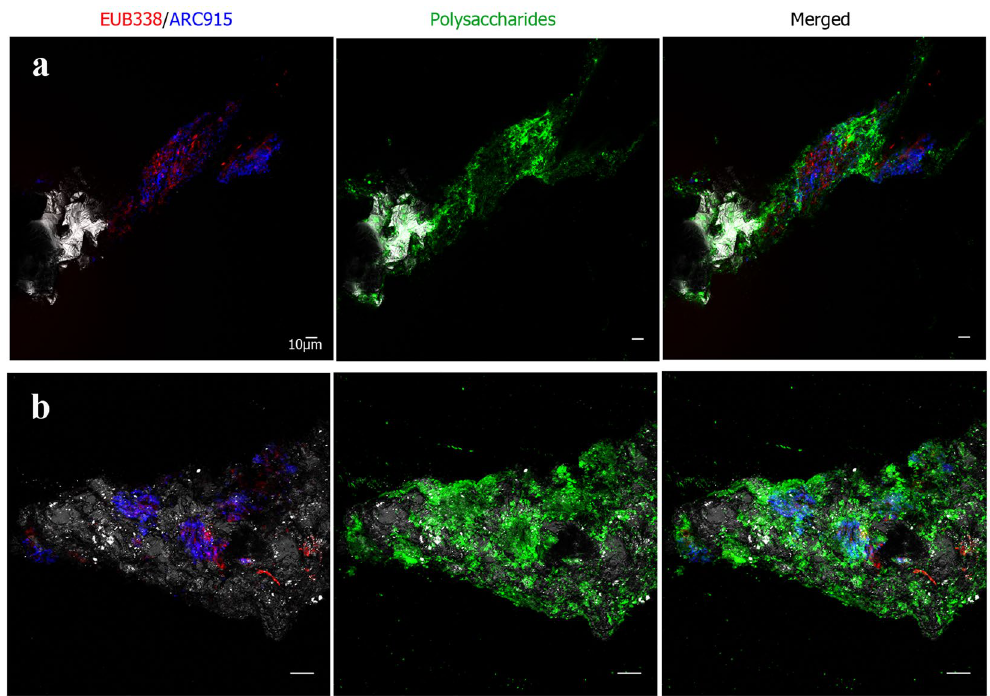
Figure 6. Detection of bacterial and archaeal mixed biofilms using double DOPE-FISH and FLBA. DOPE- FISH with bacteria (red) and archaea (blue) probes and FLBA with ConA, AAL and PNA lectins (green) at 139,4 mbs ( a , b ). Scale bar 10 μ